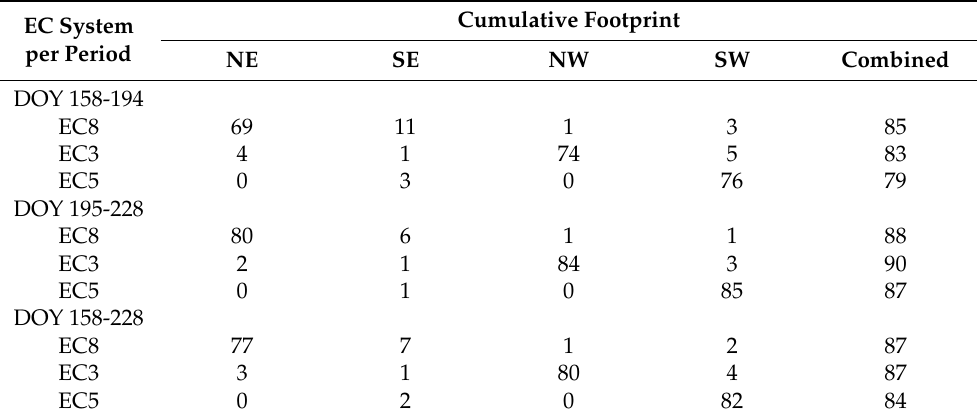
Table 5. Average Kormann and Meixner cumulative footprint (%) for each field during the different growth stages and the entire study period. EC